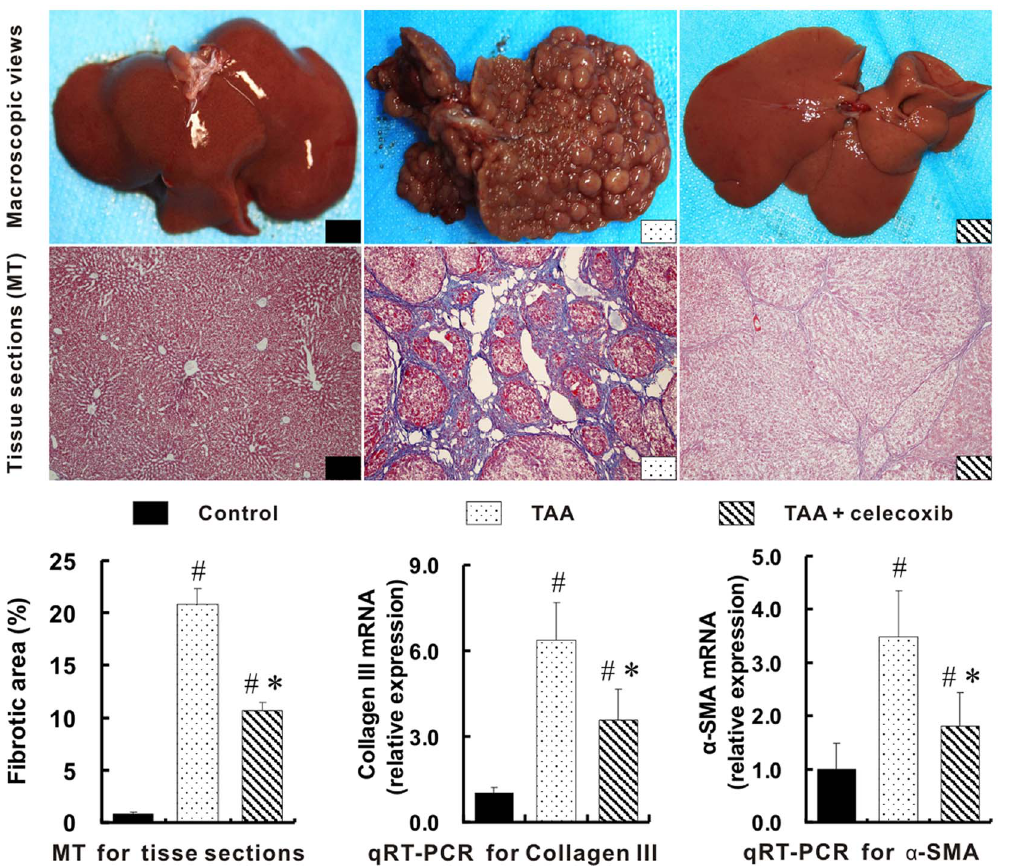
Figure 1. Reduction of hepatic fibrosis with celecoxib treatment. Compared with the livers in control group, a typical cirrhotic appearance with extensive nodular formation (middle of upper panel) was presented in the livers of TAA group. These hepatic nodules in TAA + celecoxib group were almost not observed by macroscopic view and were greatly reduced in the tissue sections (x100 magnifications) stained with MT. The percentages of fibrotic areas and expression of collagen III and a -SMA are plotted on the bottom. # p , 0.01 vs . control group; * p , 0.01 vs . TAA group.